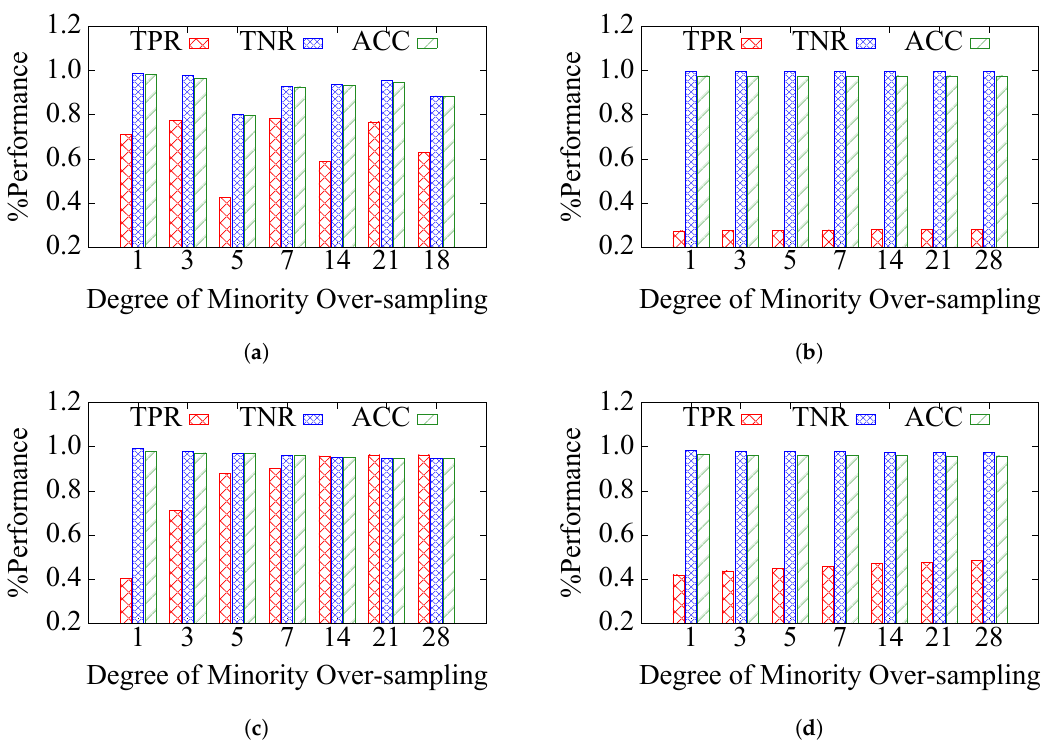
Figure 6. Different classifiers: ( a ) the ANN classifier; ( b ) the KNN classifier; ( c ) the SVM classifier and ( d ) the Bayes